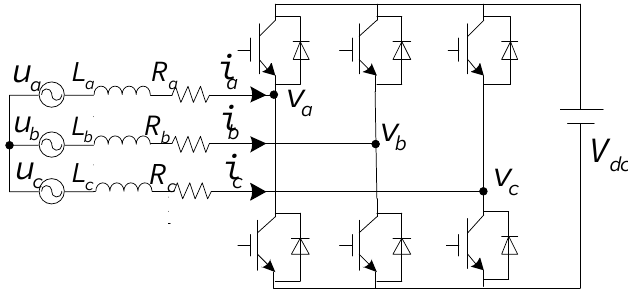
Figure 1. The circuit diagram of voltage source converter (VSC).